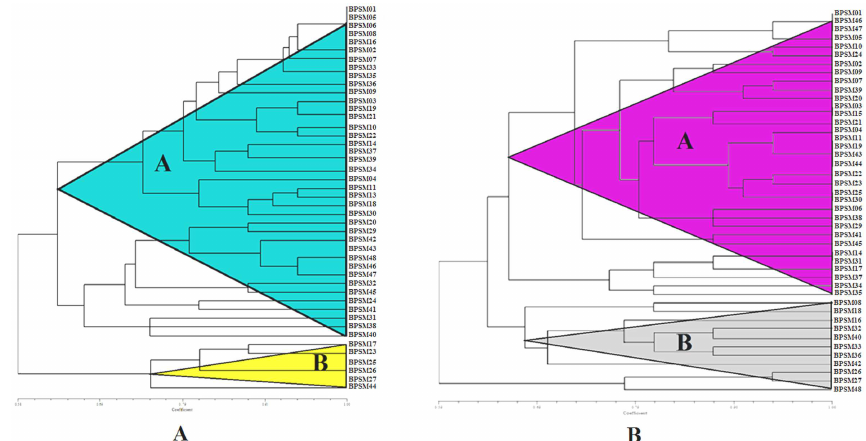
Fig 6. UPGMA dendrogram generated from (A) RAPD and (B) ISSR markersof 45 wild mushrooms using Ntsys 2.0.